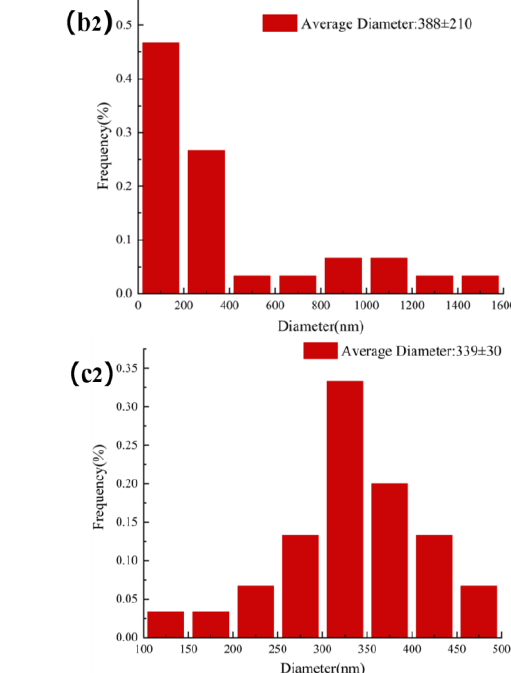
Figure 3. Morphology and corresponding diameter distribution of different NFMs (NO.0 ( a1 , a2 ), NO.1 ( b1 , b2 ), NO.2 ( c1 , c2